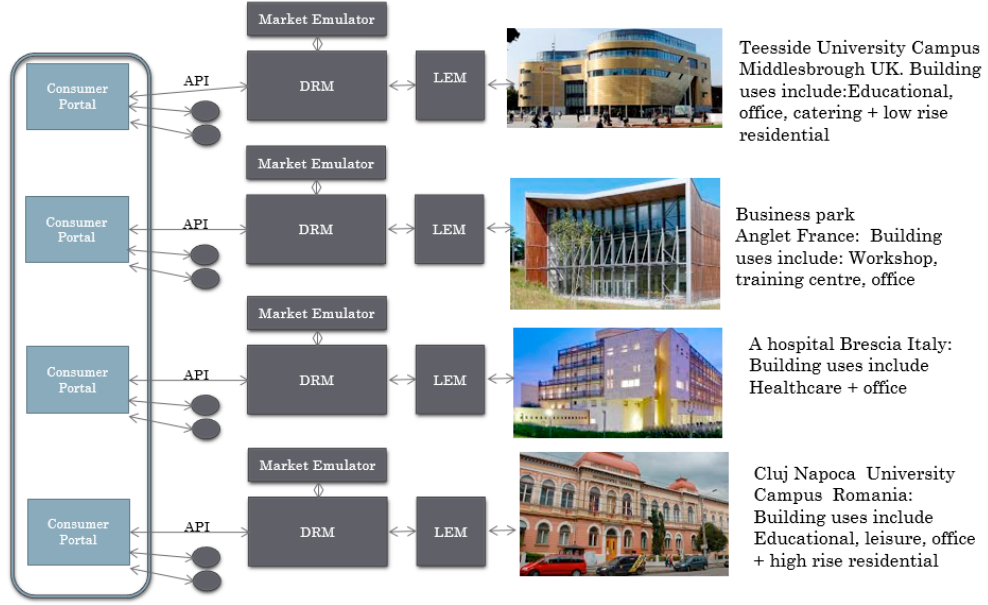
Figure 2. DR-BoB architecture implemented at four pilot sites.